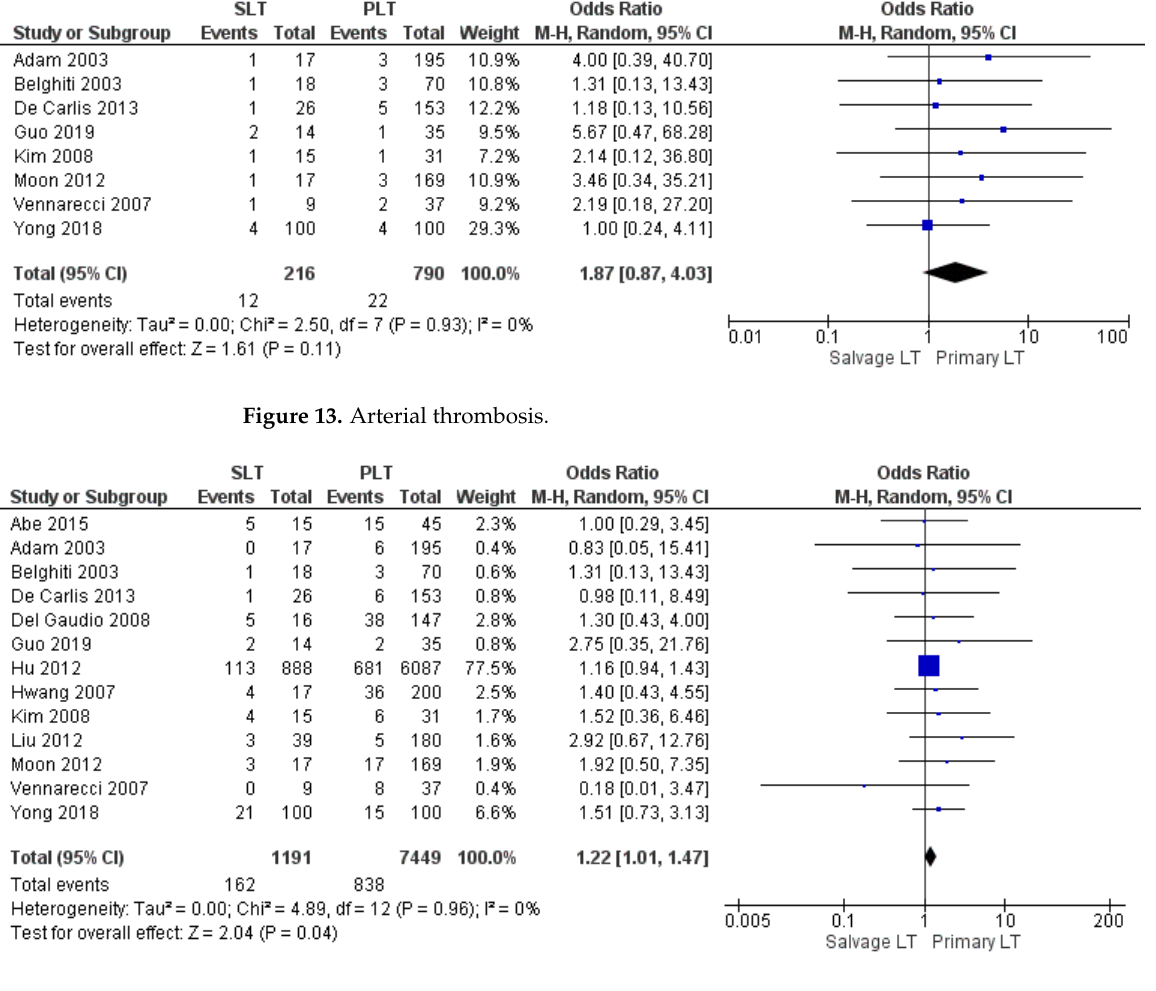
Figure 14. Biliary complication.